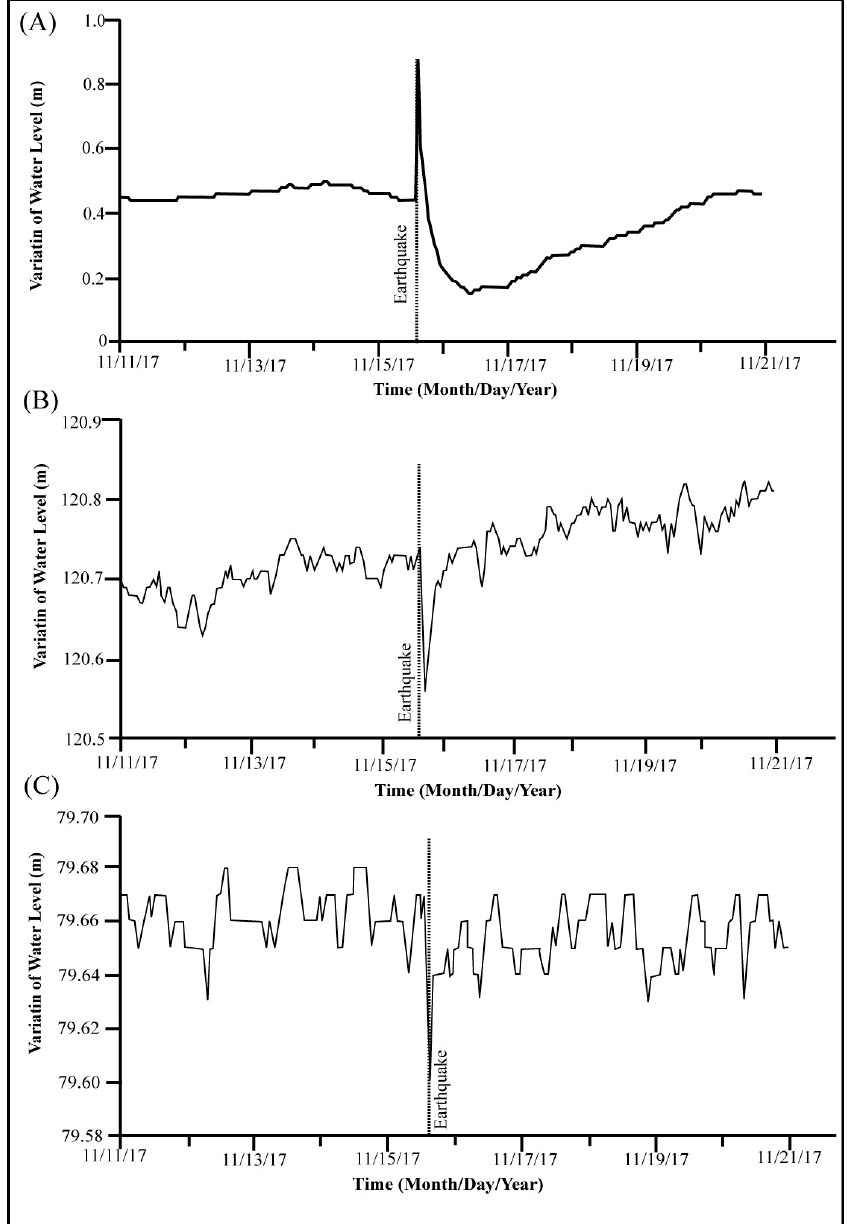
Figure 10. Changes of ground water levels associated with the Pohang earthquake. The ground water monitoring stations show the variation of the water levels before and after the 15th November 2017 Pohang earthquake ( A ) G1, ( B ) G3, and ( C ) G5. For the station locations: see Figure 3 (Data taken from https://www.groundwater.or.kr).